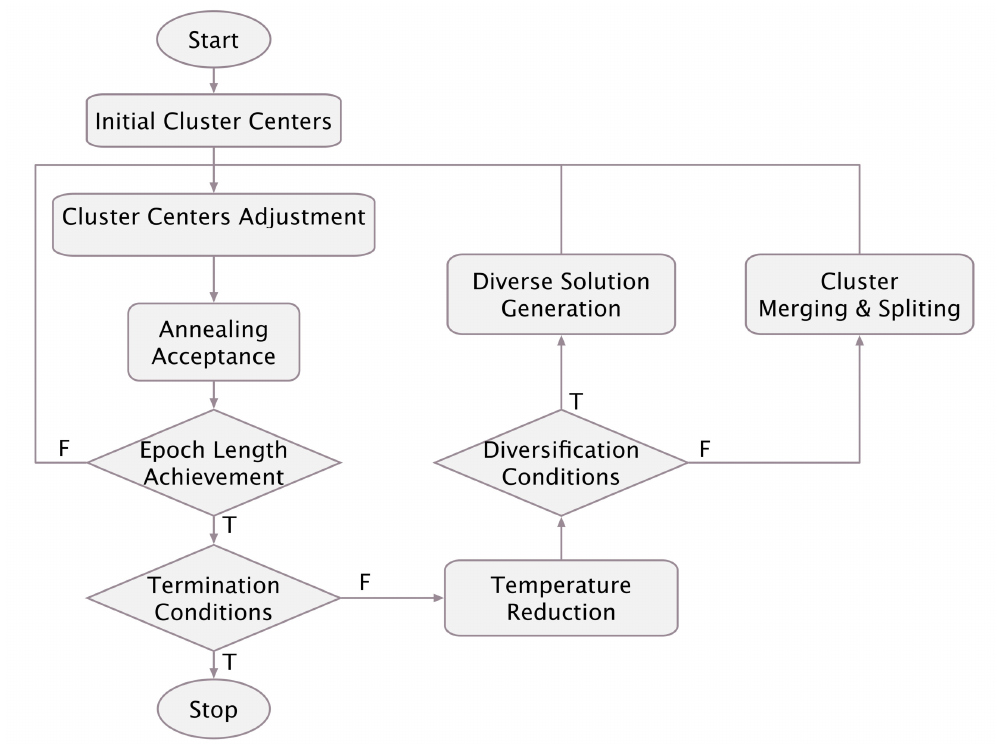
Figure 6. KMC flowchart.